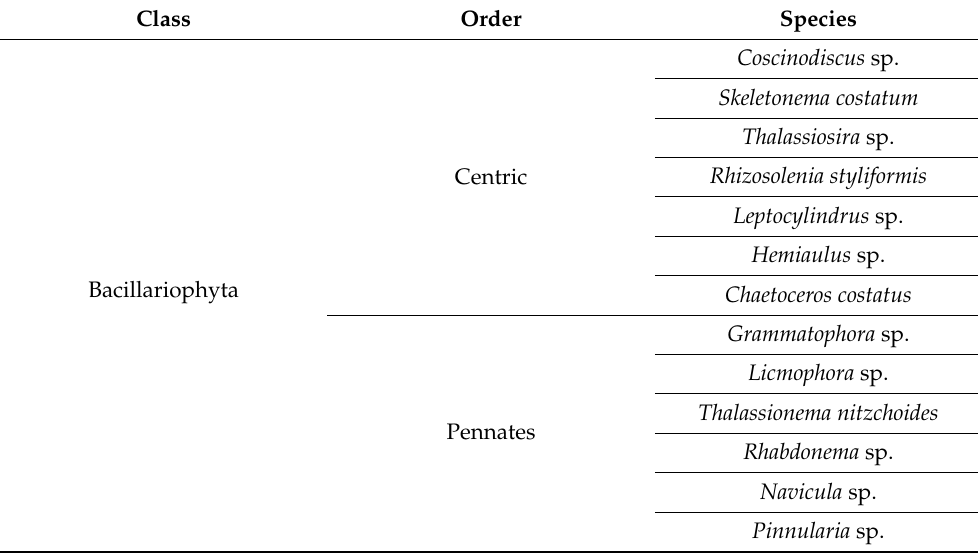
Figure 4. Spatial variation of abundance of total phytoplankton and Chl- a concentrations at 15 stations (S) grouped in 5 transects (T) in the marine coastal area of Gulf of Gab è s. A total of 42 phytoplankton taxa were identified, consisting of 20 Dinophyta, 18 Bacillariophyta, 2 Cyanobacteriae, 1 Euglenophyceae, and 1 Dictyochophyceae (Table 2). Four potentially toxic species of Dinophyta ( Amphidinium carterae , Dinophysis caudata , Prorocentrum lima , Prorocentrum minimum ) and one of Bacillariophyta ( Pseudonitzchia sp.) were recognized. Table 2. Species composition of phytoplankton collected at 15 stations in the Gulf of Gab è s. * : Toxic taxa. Class Order Species Coscinodiscus sp. Skeletonema costatum Thalassiosira sp. Rhizosolenia styliformis Centric Leptocylindrus sp. Hemiaulus sp. Bacillariophyta Chaetoceros costatus Grammatophora sp. Licmophora sp. Thalassionema nitzchoides Pennates Rhabdonema sp. Navicula sp. Pinnularia